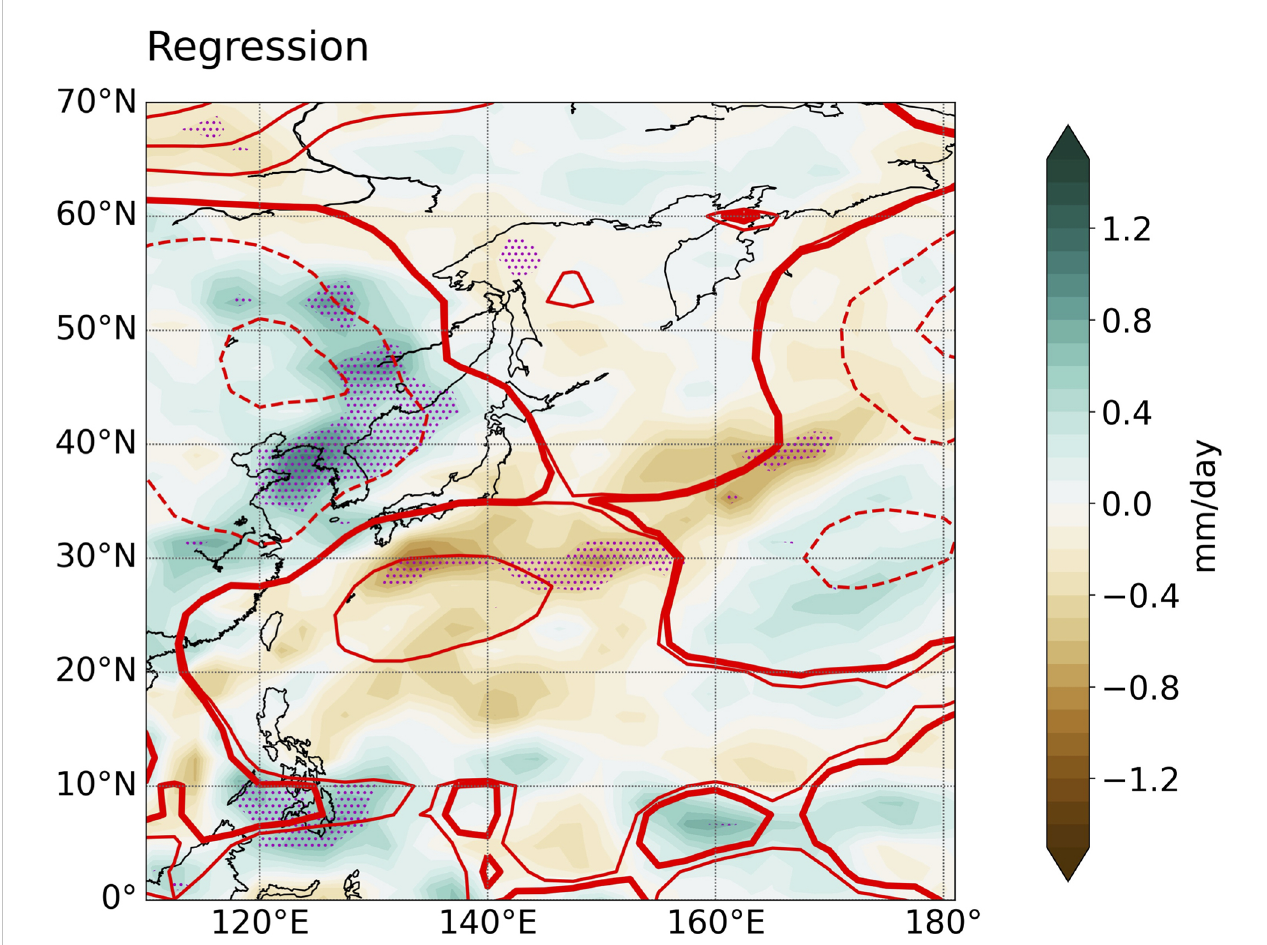
FIGURE 5 Same as Figure 4, except for the linear regression coef fi cients of the monthly mean anomalies of the SLP and PREC associated with the standardized monthly counts of the days of strong wind (top